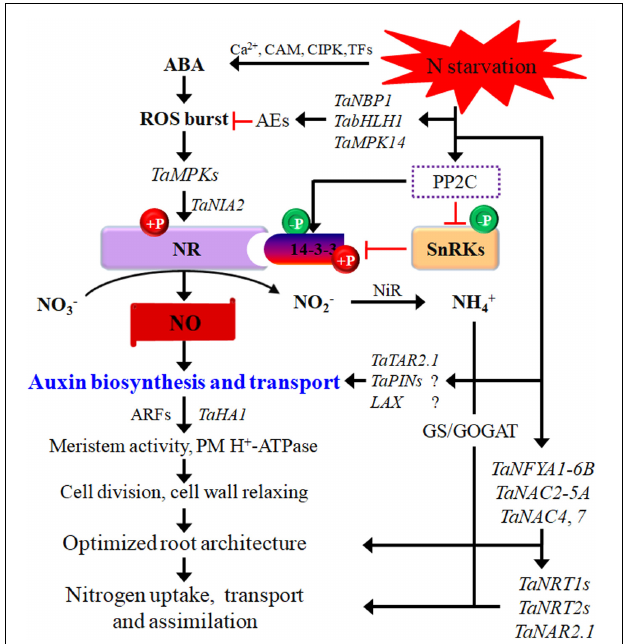
FIGURE 1 | Potential pathways regulating wheat responses to low-N stress. N starvation interacts with phytohormones signaling. The interactions between them regulate root cell activity via ARFs and thus modify the root system architecture. Black arrows indicate positive regulation of N transport or assimilatory pathways, and red lines with short vertical columns indicate negative signaling steps. AEs, antioxidant enzymes; ARF, auxin responsive factors; bHLH, basic helix–loop–helix; GOGAT, glutamate synthase; GS, glutamine synthetase; MPK, mitogen-activated protein kinase; NBP, nucleotide-binding protein; NFYA, nuclear factor Y subunit A; NR, nitrate reductase; SnRKs, SNF1-related protein kinases; TAR, tryptophan aminotransferase-related. Question marks in the figure indicate that the important components in low-N signaling networks remain to be elucidated in